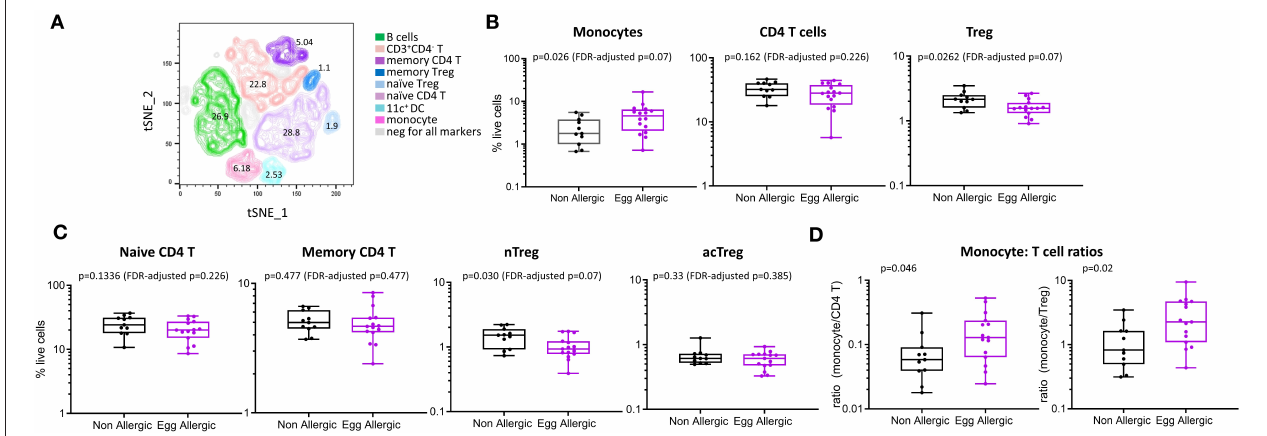
FIGURE 2 | Immune cell profiling shows altered circulating monocyte and CD4T cell profiles in egg allergic infants. (A) tSNE representation of live single cells [270,000 randomly selected cells (10,000 cells per participant)]. The generated tSNE clusters were classified into the following cell types based on expression of lineage markers: B cells (green), memory CD4T cells (dark purple), naïve CD4T (light purple), memory Treg (dark blue), naïve Treg (light blue), monocyte (pink), CD11c + dendritic cells (aqua), CD3 + CD4 − T cells (orange). (B) Monocytes, CD4T cells and Treg expressed as proportion of total live cells in non-allergic (black), and egg allergic (purple) infants. (C) Naïve CD4T, memory CD4T, naïve Treg (nTreg), and activated Treg (acTreg) expressed as proportion of total live cells in non-allergic (black) and egg allergic (purple) infants. (D) Monocyte: CD4T cell ratios for total CD4T cells and Tregs in non-allergic (black) and egg allergic (purple)